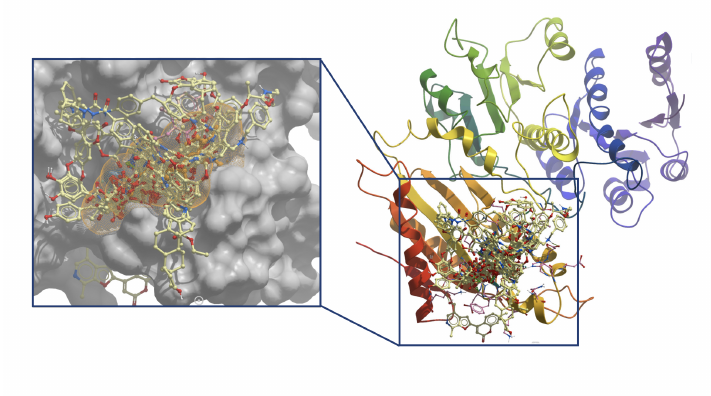
Figure 3. Best poses for the first 100 hits ranked according to ICM energy score. Orange dot envelope represents the space found in the average structure of GTP.